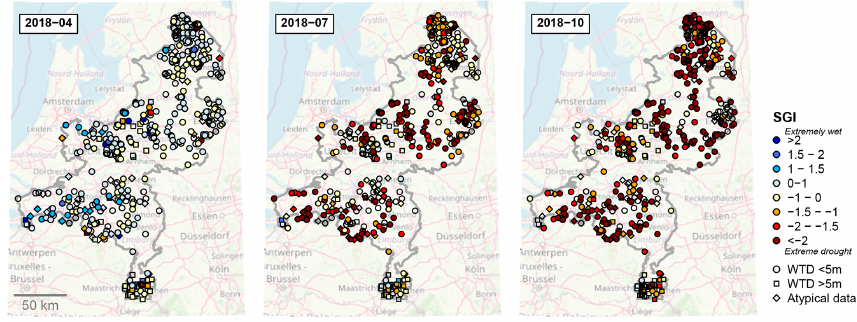
Figure 9. SGI for April, July, and October 2018 based directly on cleaned long measurement series. Empty symbols indicate insufficient data to enable drought index